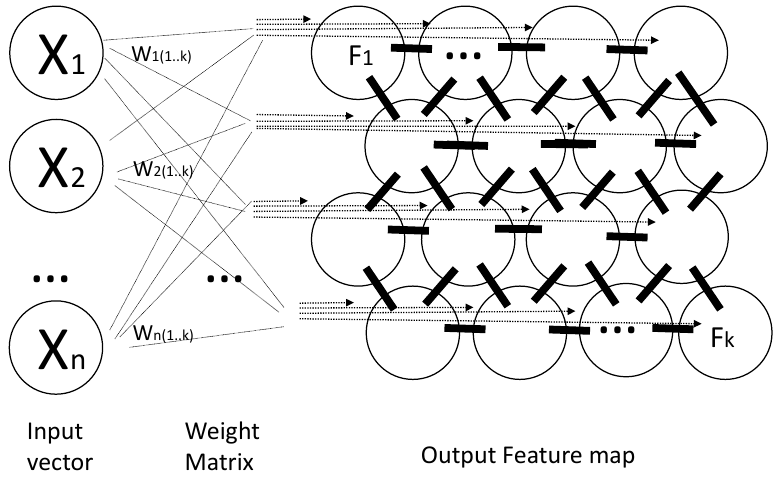
Figure 2. Example of SOM